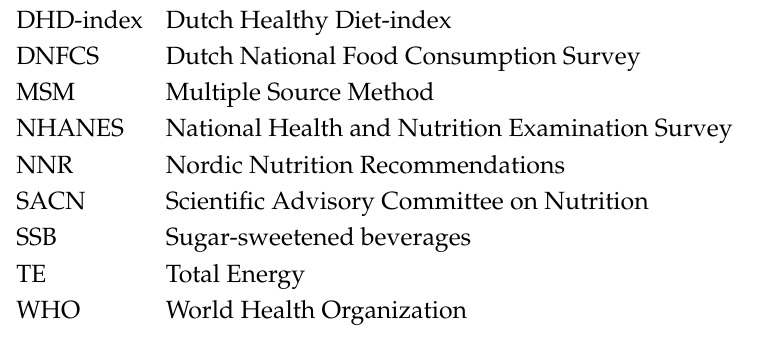
Table S1: Decision flow-chart of estimated added sugar content of 2556 foods from the Dutch food composition table 2011 by product groups, largely based upon the criteria of the International Scientific Committee of Choices